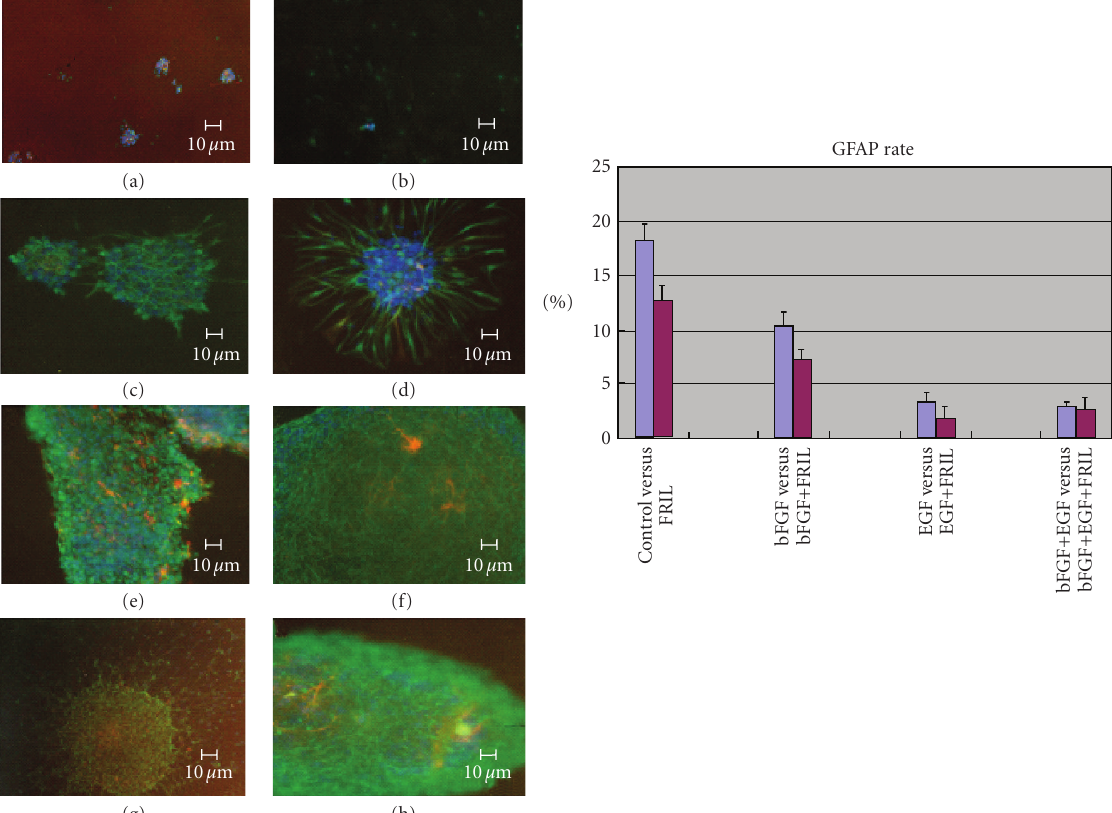
Figure 4: GFAP and nestin immunofluorescence on NPCs cultured in di ff erent media. (a) NPCs in control medium. (b) NPCs in FRIL medium. (c) NPCs in bFGF medium. (d) NPCs in bFGF&FRIL medium. (e) NPCs in EGF medium. (f) NPCs in EGF&FRIL medium. (g) NPCs in bFGF&EGF medium. (h) NPCs in bFGF&EGF&FRIL medium. GREEN nestin, RED GFAP, BLUE